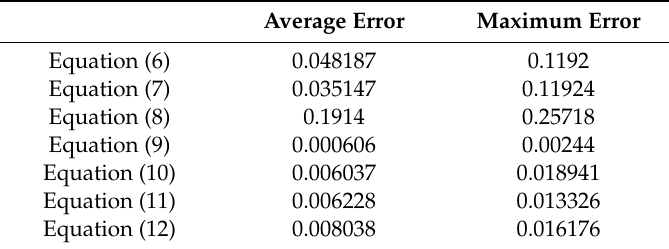
Table 1. The average and maximum errors of Equations (6)–(12).